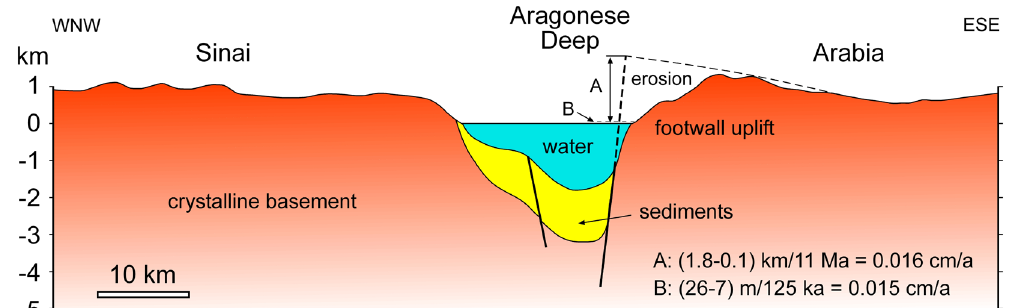
Figure 8. Topographic and bathymetric profile across the deepest part of the Gulf of Aqaba (Aragonese Deep) in the general vicinity of the 22 November 1995 M S 7.2 earthquake 14, 15 and our coral terrace station 12 (Figs 2 and 3 and Table 1). Structure of the Aragonese Deep is modified from ref. 48. The east Aragonese Deep bounding fault complex has a large extensional component which drives the footwall uplift. Two uplift rate calculations are shown: A–uplift since the minimum age of initiation of the Gulf of Aqaba at 11 Ma (assuming paleo-sea-level 100 m higher than today); and B–uplift since the MIS5e interglacial at 125 ka (assuming paleo- sea-level was 7 m higher than